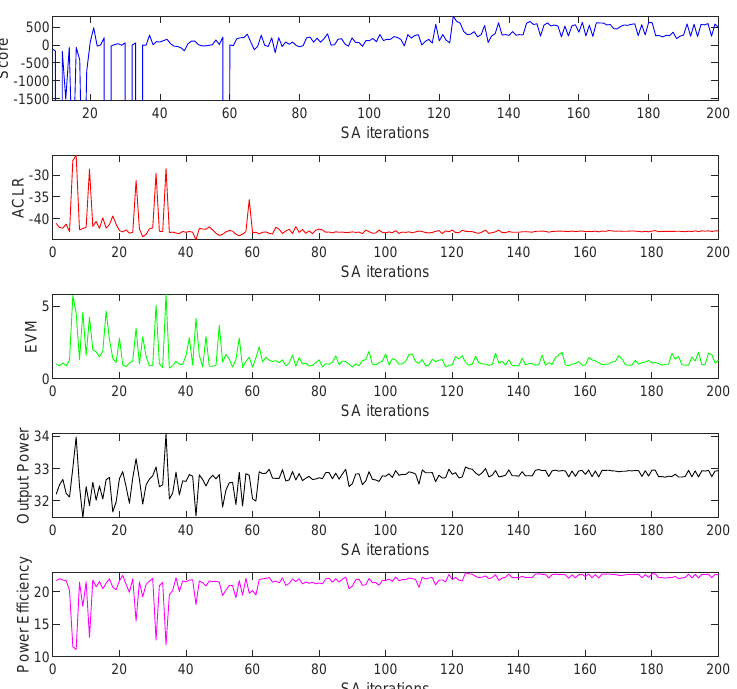
Figure 12. Evolution of the FOMs along different SA iterations for the CA-4 × LTE-20 signal test